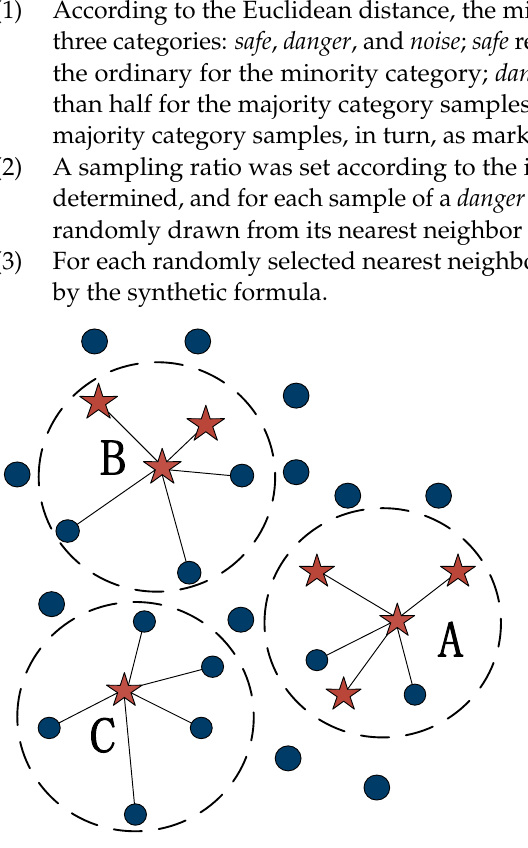
Figure 2. Classification rules for minority class samples.